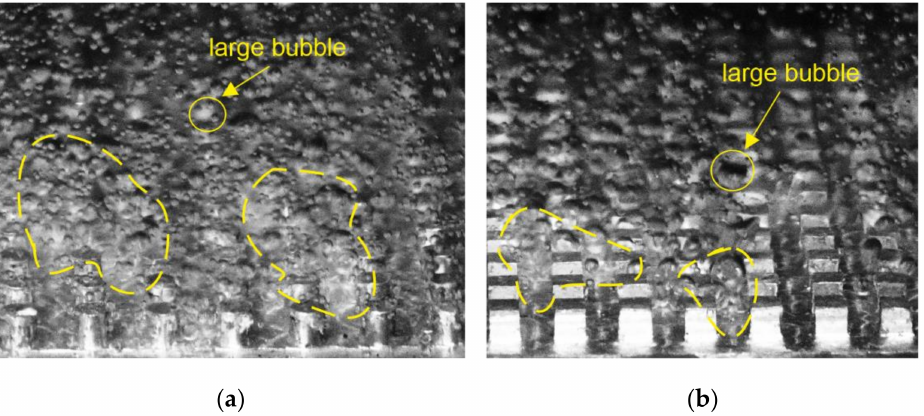
Figure 7. Phenomenon of merged bubble regime observed from: ( a ) 1 mm gap circular pin fin array at q” = 23.0 W/cm 2 ; ( b ) 1 mm gap rectangular pin fin array at q” = 23.6 W/cm 2